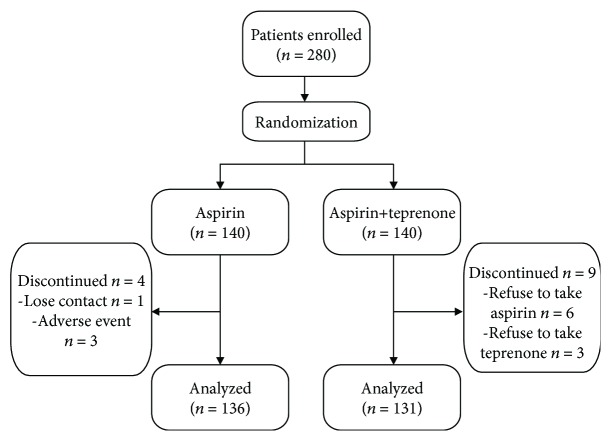
Study flowchart.